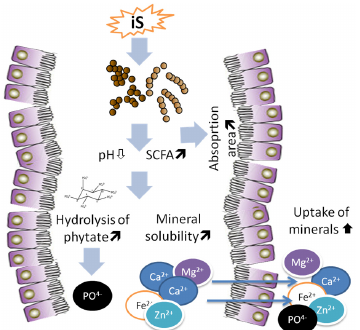
Figure 3. Description of the effects of dietary indigestible sugars (iS) on formation of short chain fatty acids (SCFA) and mineral absorption in the hindgut in rats.